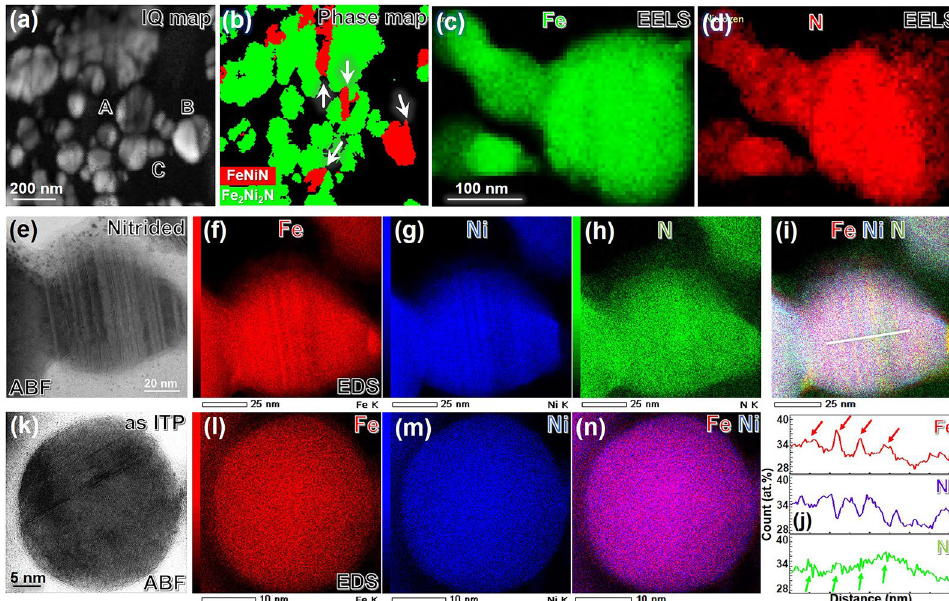
Figure 3. Correlation between FeNiN phase and nanotwins. ( a ) TKD image quality (IQ) map and ( b ) TKD phase map of the nitrided FeNi NPs. The interfaces between the FeNiN (in red) product phases and Fe 2 Ni 2 N (in green) parent phases are indicated with the white arrow in the phase map ( b ). EELS elemental maps of ( c ) Fe and ( d ) N of nitrided FeNi NPs marked as “ B ” in the IQ map ( a ). Angular bright-field STEM images ( e , k )